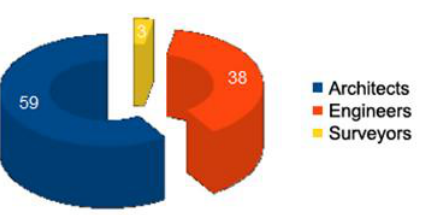
Figure 2. Degree distribution for the Master Attenders: Engineers, Architects and Surveyors percentage visualization (Figure by P. Fiamma).